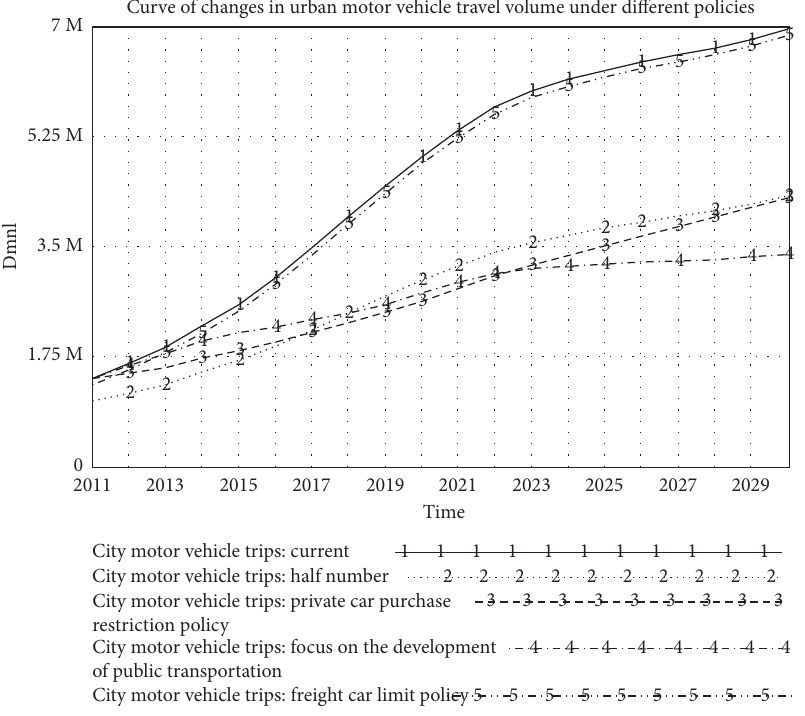
Figure 13: City motor vehicle travel volume under policy